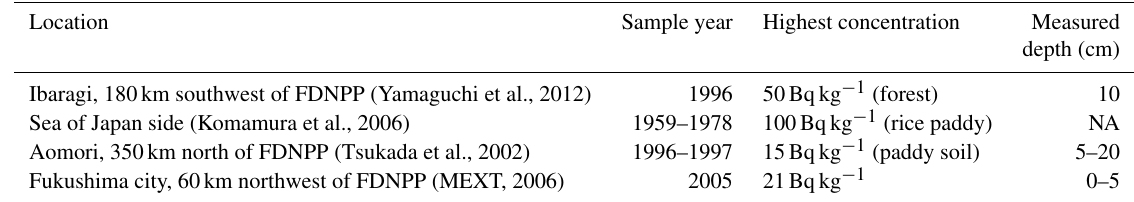
Table 3. Background levels of Cs-137 in soils in Japan before the FDNPP accident (the highest concentration at a measured soil depth). NA stands for not available.